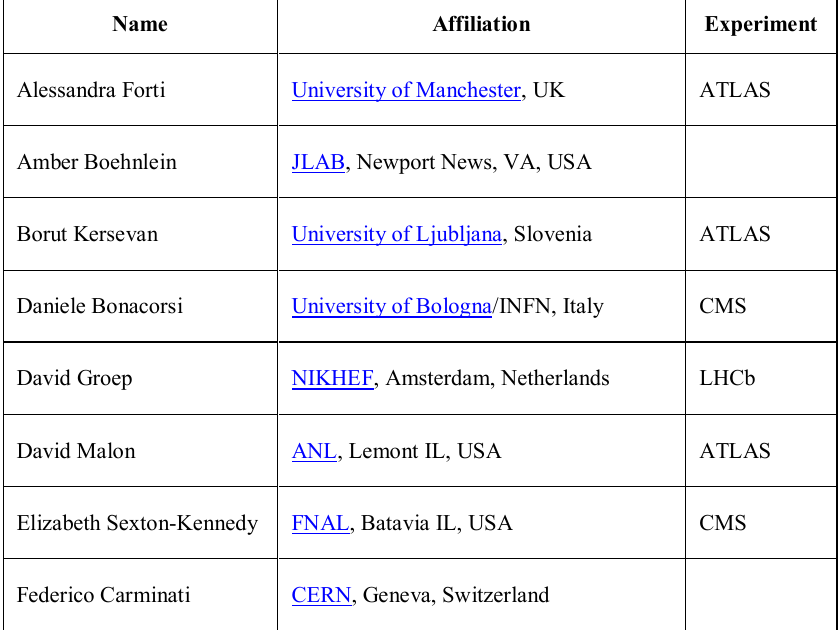
Table 3. Members of the International Advisory Committee